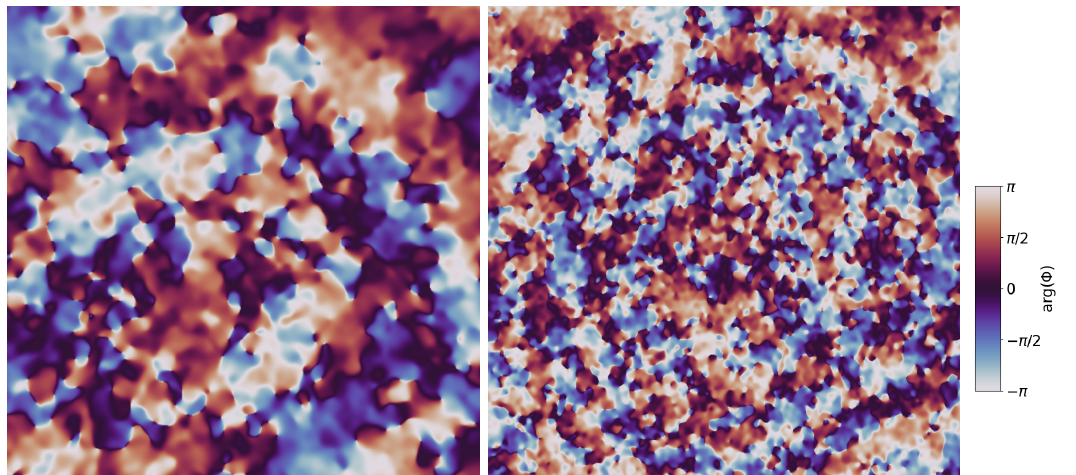
= 100 (left) and λ/g 2 = 400 (right) at D D is D